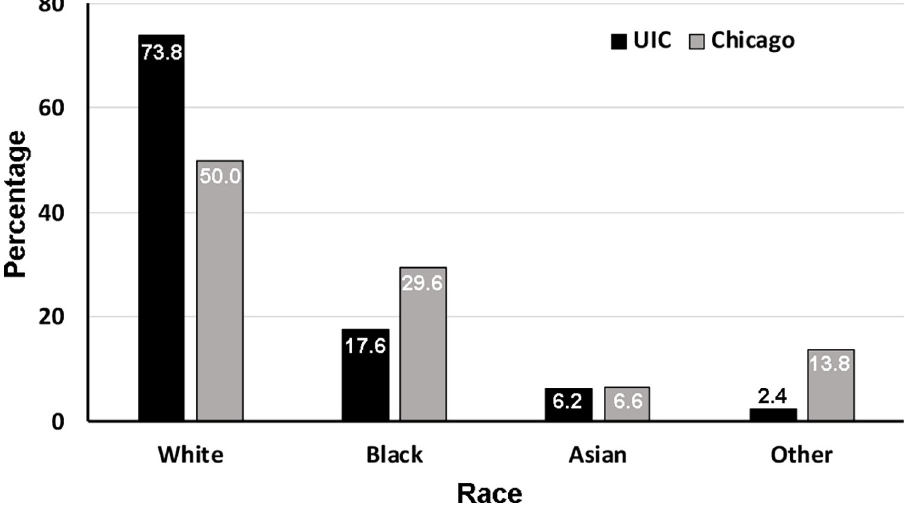
Fig 2. Comparison of the population by race between the patients at UIC orthodontic clinic and City of Chicago. The similar distribution of races between the orthodontic patients at UIC and the population of the City of Chicago was shown. The majority of the patients were white. Black bars: UIC; Gray bars: City of